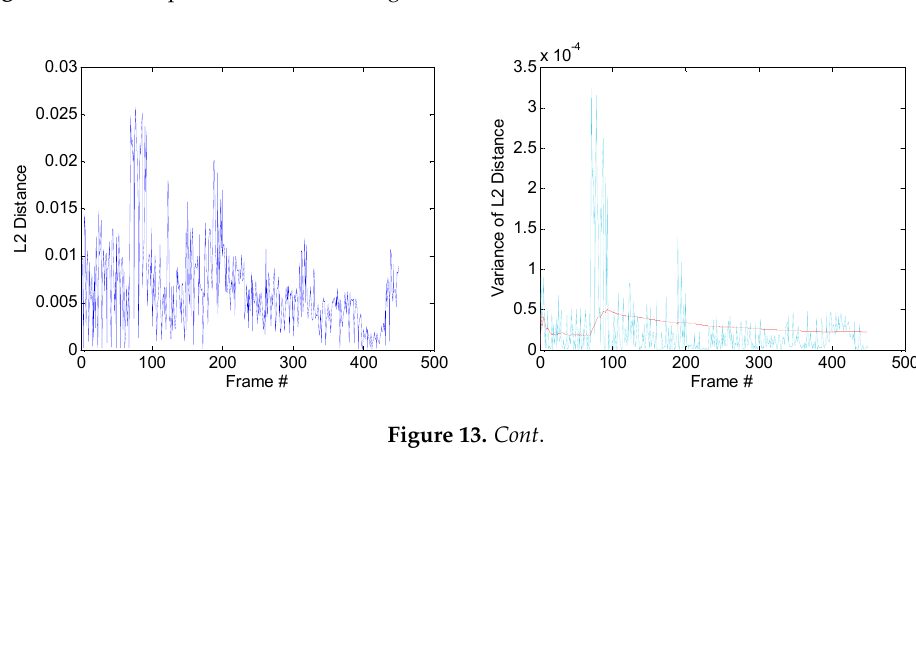
Figure 12. Overall performance of the Regional-Distribution Tracker with different normalization.